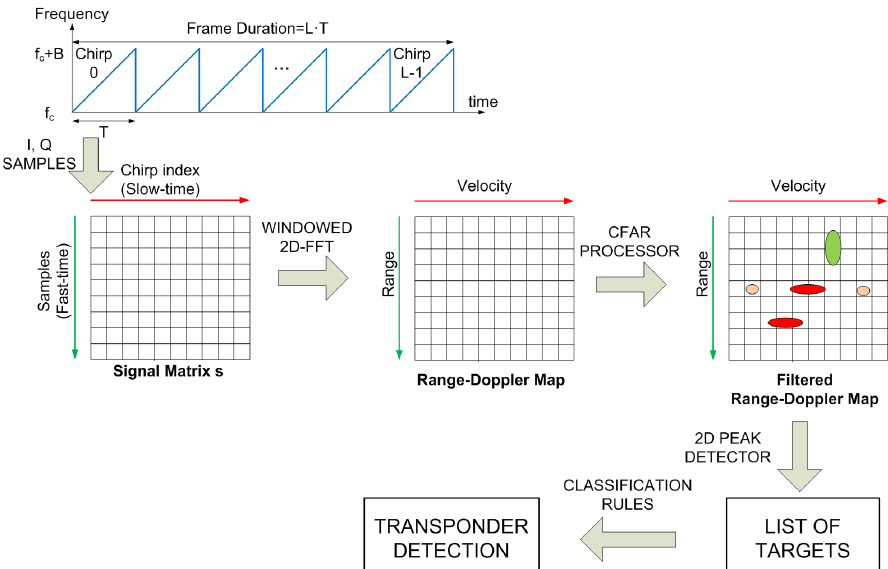
Figure 7. Range-Doppler matrix computation from the IQ samples and flow-chart of the signal pro-